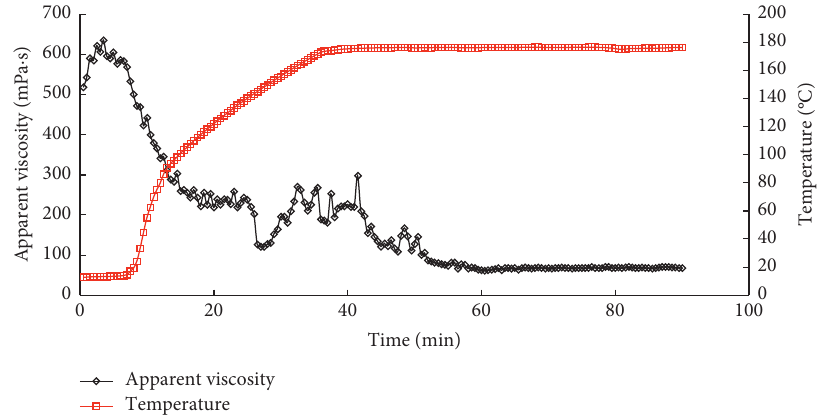
Figure 6: Temperature and shear resistance of the high-density fracturing fluid of formula 2.